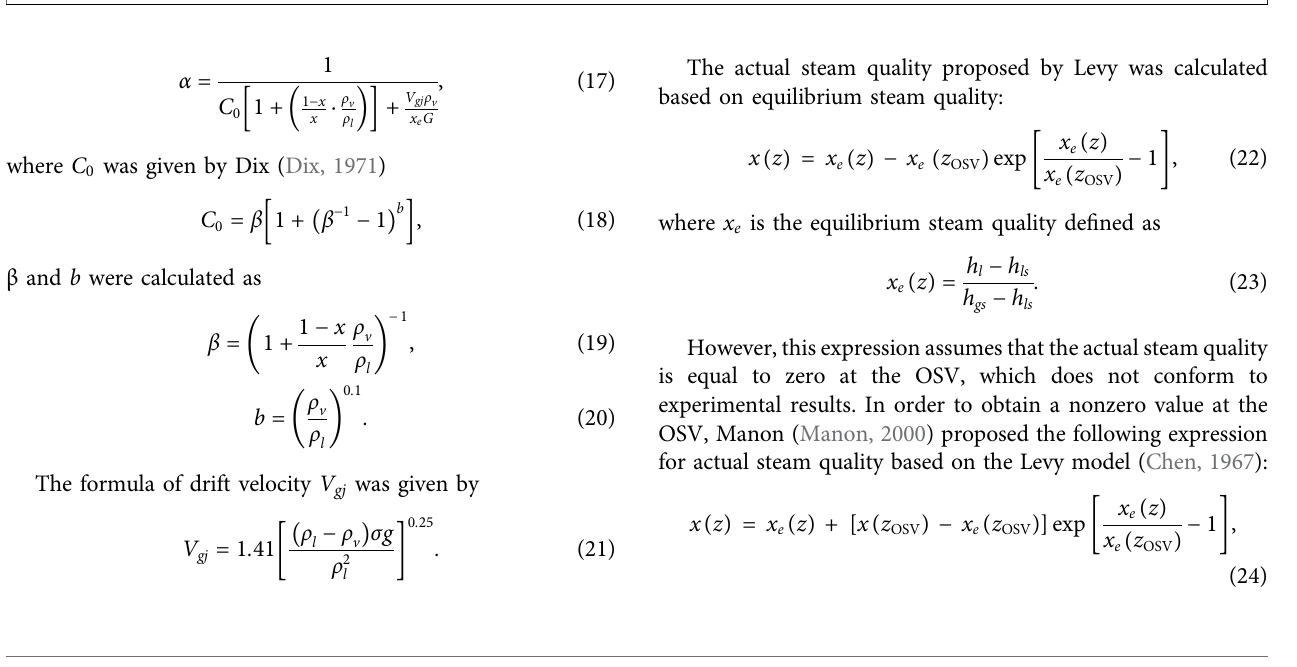
FIGURE 10 | Averaged void fraction as a function of x e under different coolant pressures and mass fl uxes.